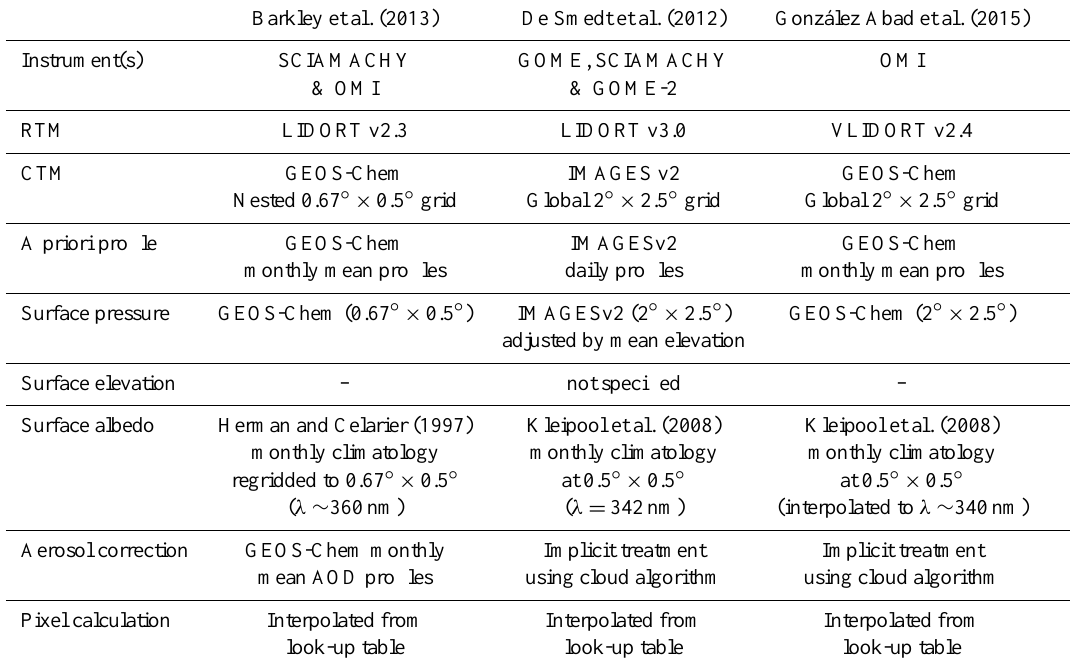
Table 1. Comparison of three different contemporary HCHO AMF calculations. Readers are referred to cited references for full details. Barkley et al.